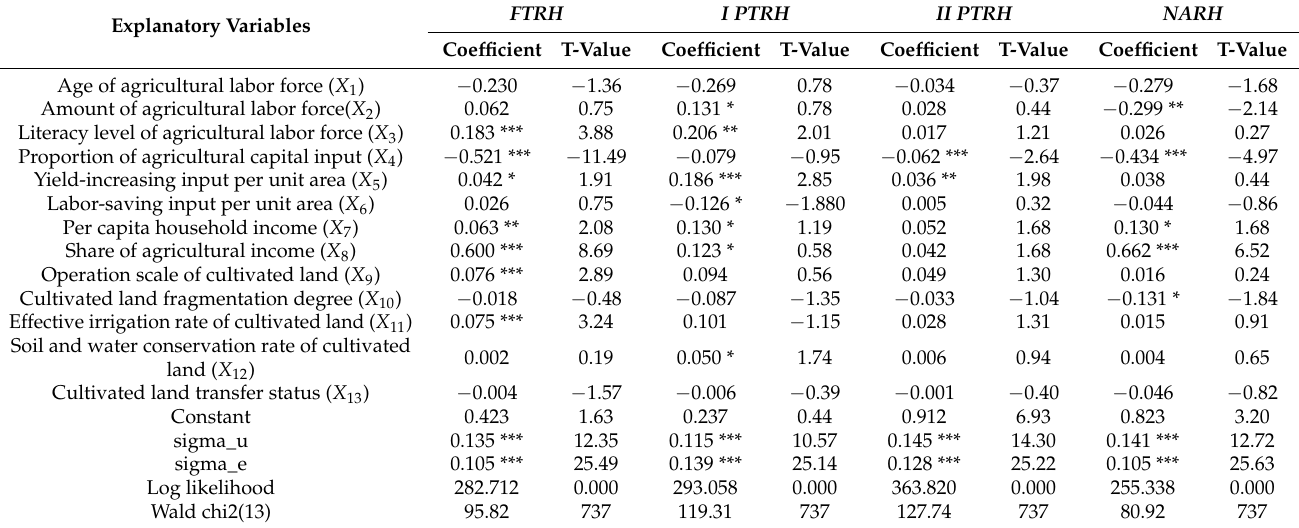
Table 7. The Tobit regression results of CLUE of different types of rural